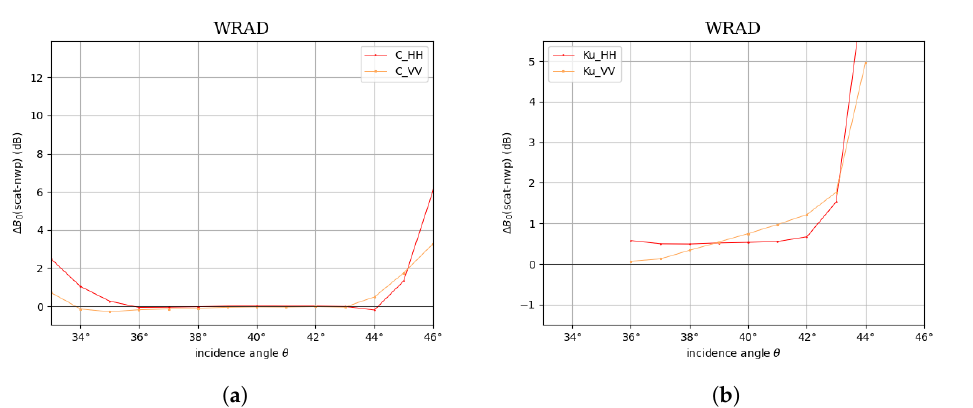
Figure 8. NOC as a function of incidence angle for descending orbits: ( a ) C-band HH and VV polarization; ( b ) Ku-band HH and VV